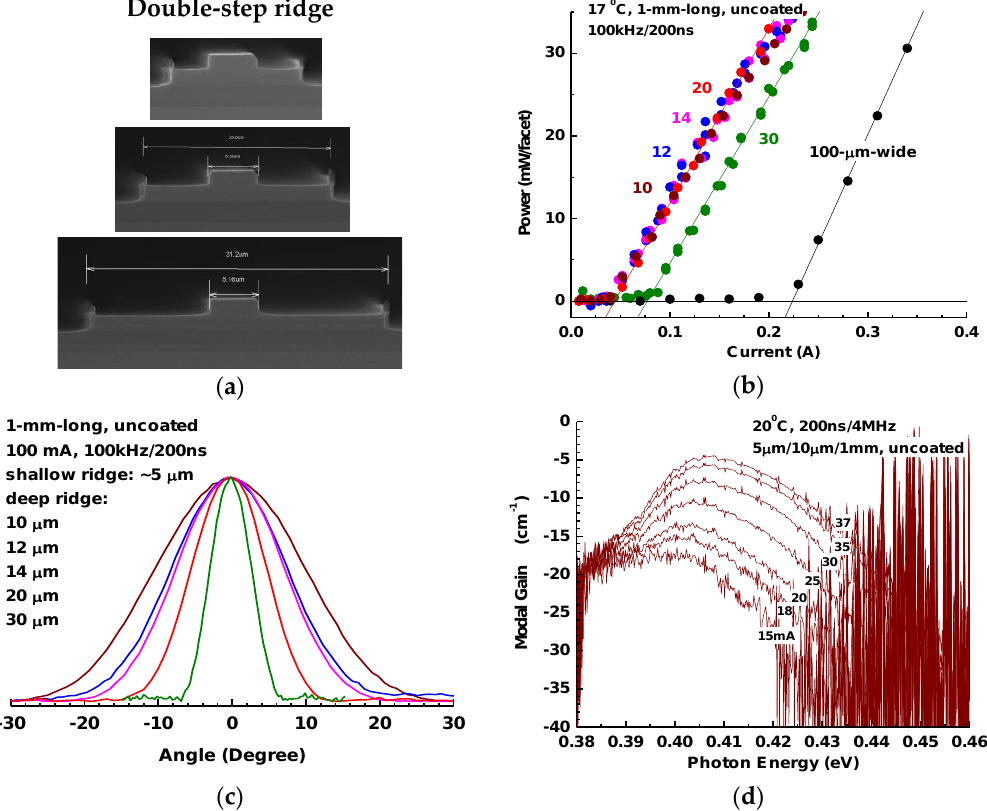
Figure 4. ( a ) Cross-sectional scanning electron microscope image of the two-step ridge waveguide structure with a shallow ridge width of ~5 μm and deep-etched section widths of ~14, ~20, and ~30 μm (image is taken prior to dielectric deposition and metallization). ( b ) Light-current characteristics measured at 17 °C in a short-pulse regime (200 ns/100 kHz) for 1 mm-long, 100-μm-wide, uncoated double-step ridge waveguide three-stage cascade lasers with a 5-μm-wide shallow ridge and deep ridge width ranging from 10 to 30 μm. Reference LI is measured for 100-μm-wide single-step deep-ridge lasers. ( c ) Slow axis far-field patterns measured at 100 mA for devices with fixed ~5 μm-wide narrow shallow ridge and variable wide deep-etched ridges (the widest beam corresponds to devices with 10-μm-wide deep ridge). ( d ) Modal gain spectra measured at several currents below threshold for three-stage cascade lasers with 5-μm-wide shallow and 10-μm-wide deep ridges.